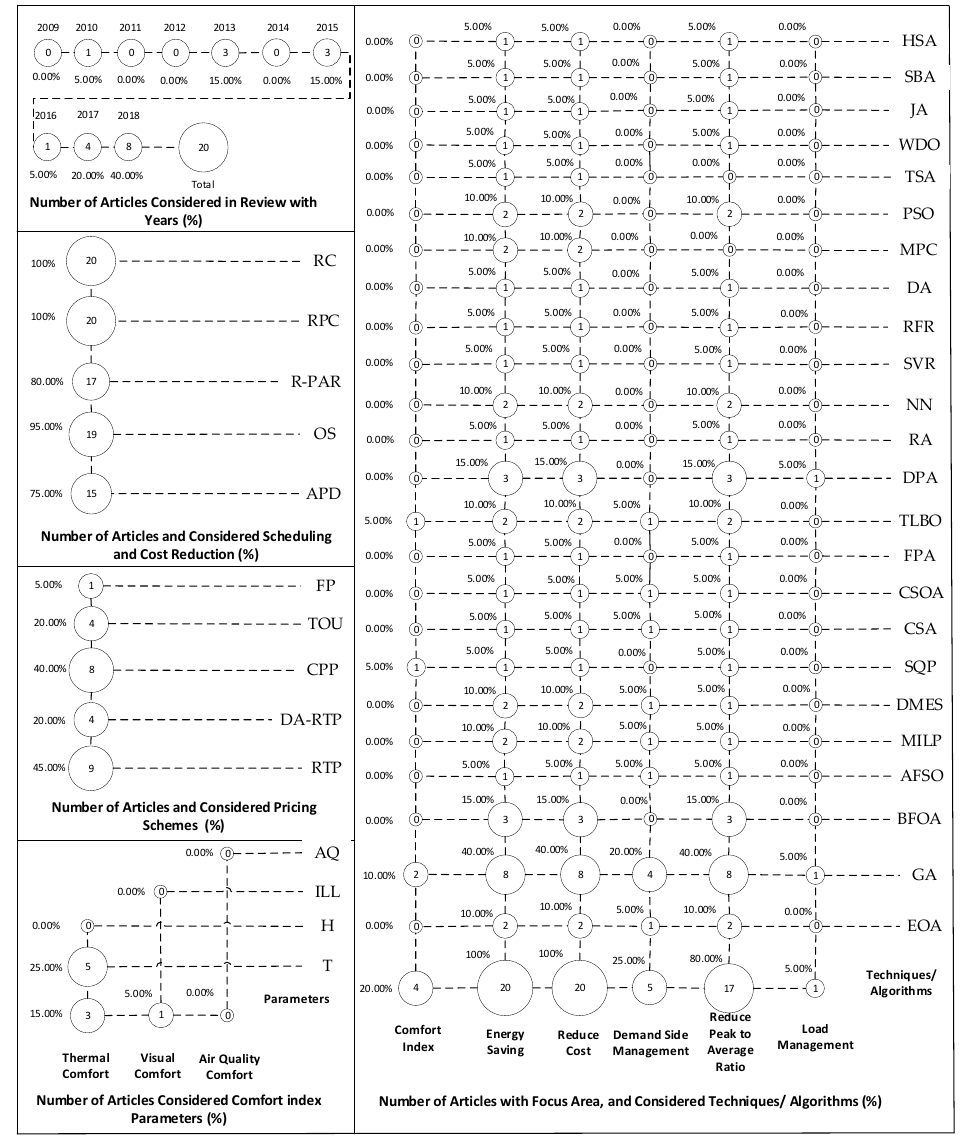
Figure 3. Visualization of a systematic map of scheduling techniques.